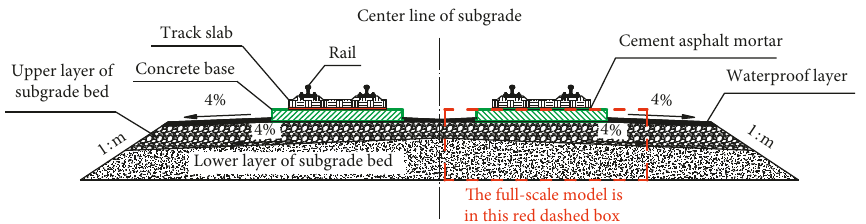
Figure 1: The cross section profile of the slab track-subgrade close to the expansion joint of the concrete